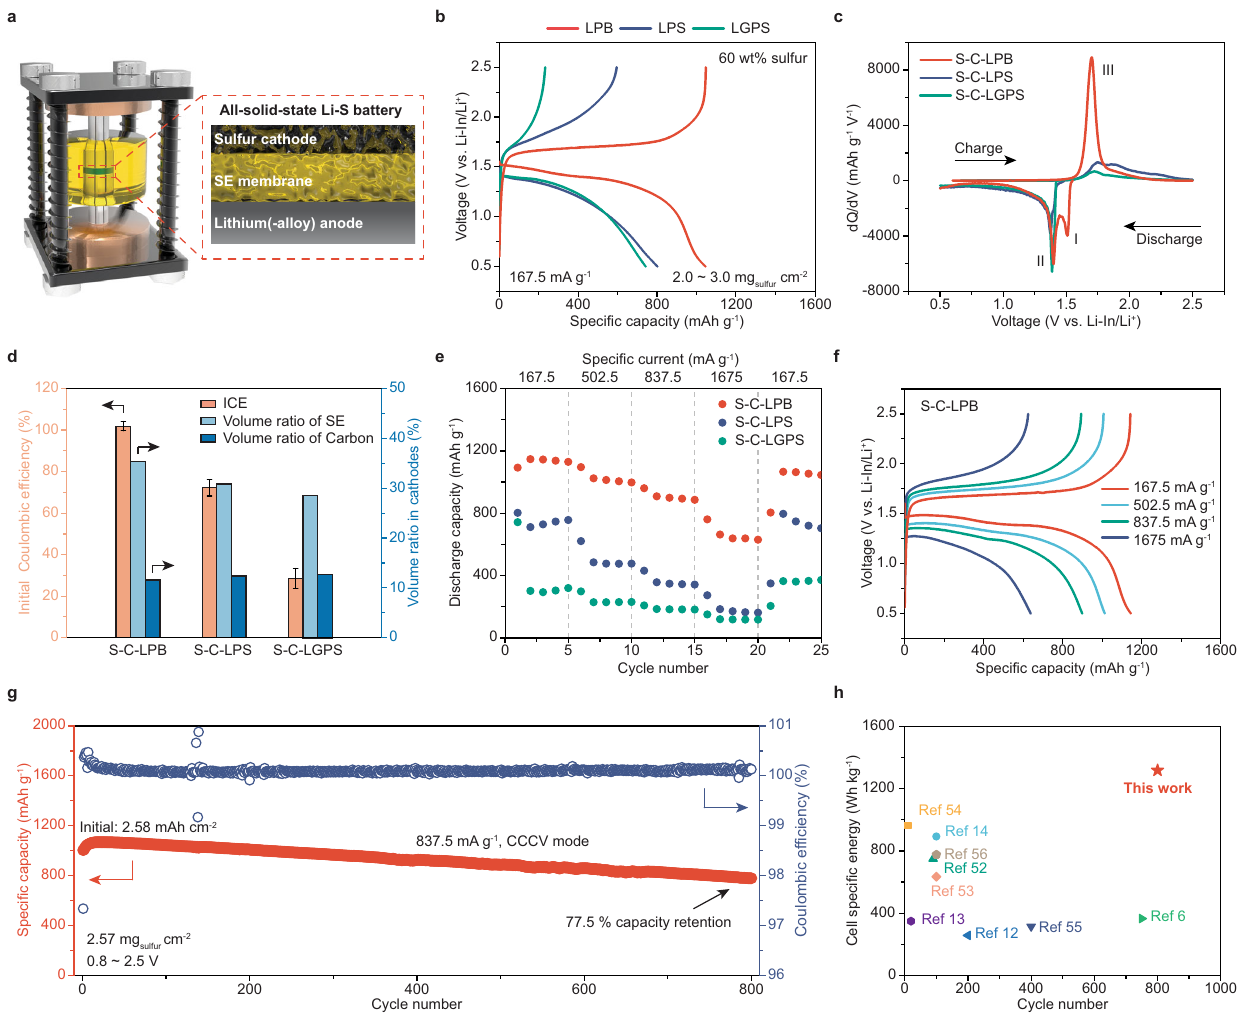
Fig. 3 | Battery testing of Li-In|LPB|S-C-SE all-solid-state cells. a Schematic illustrationoftheSwagelokcellandthecon fi gurationofLi-SASSBs. b Galvanostatic discharge-charge curves of S-C-LPB, S-C-LPS, and S-C-LGPS cathodes upon 167.5mAg − 1 at 60°C. c Differential capacity vs. voltage (dQ/dV) curves. d Comparison of initial Coulombic ef fi ciency (ICE, charge capacity/discharge capacity) and volume ratios of SE and carbon in different cathodes. The error bar represents the standard deviation of average ICE. e Rate performance of different sulfur cathodes and f corresponding voltage pro fi les of S-C-LPB cathode at